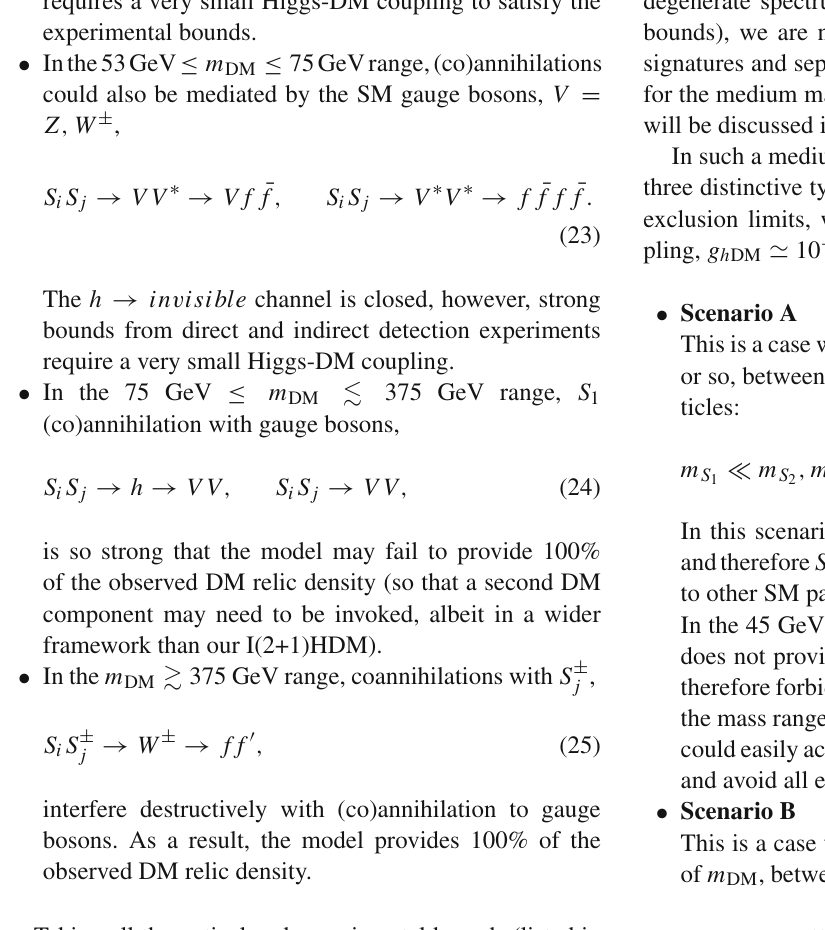
Fig. 1 The only tree-level contribution to the direct detection cross- section is from the tree-level S 1 N → S 1 N process mediated by the − m (cid:14) few keV ( j = 2 , 3 , 4), the Higgs boson (left). With m S S 1 j